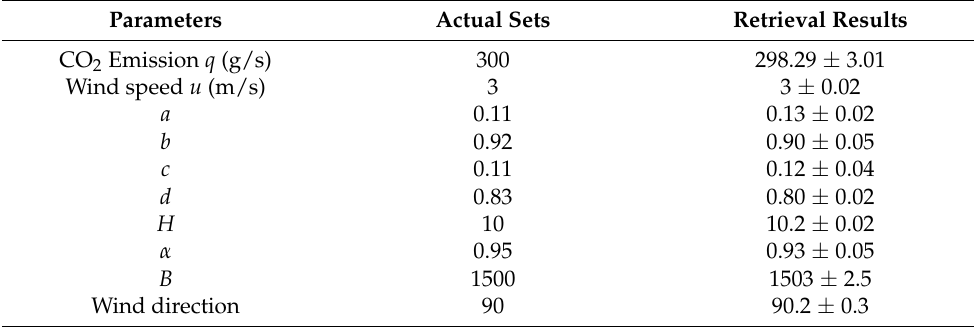
Table 1. Parameters of Gaussian plume model and the retrieval